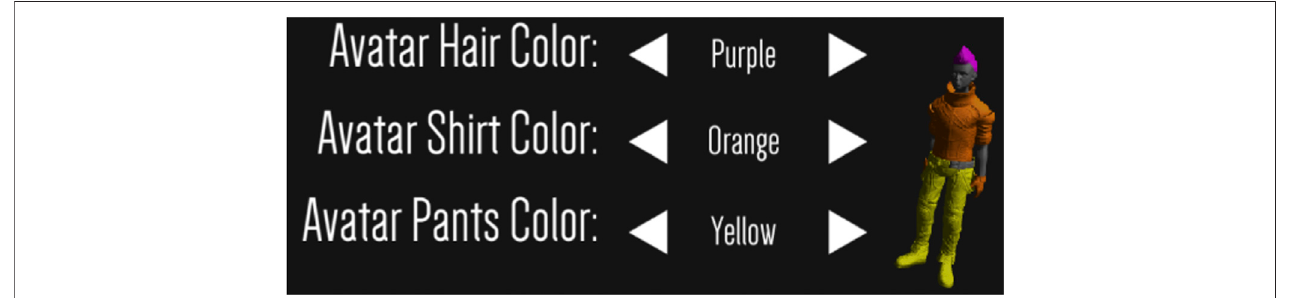
FIGURE 3 | NeuroRunner avatar customization screen.